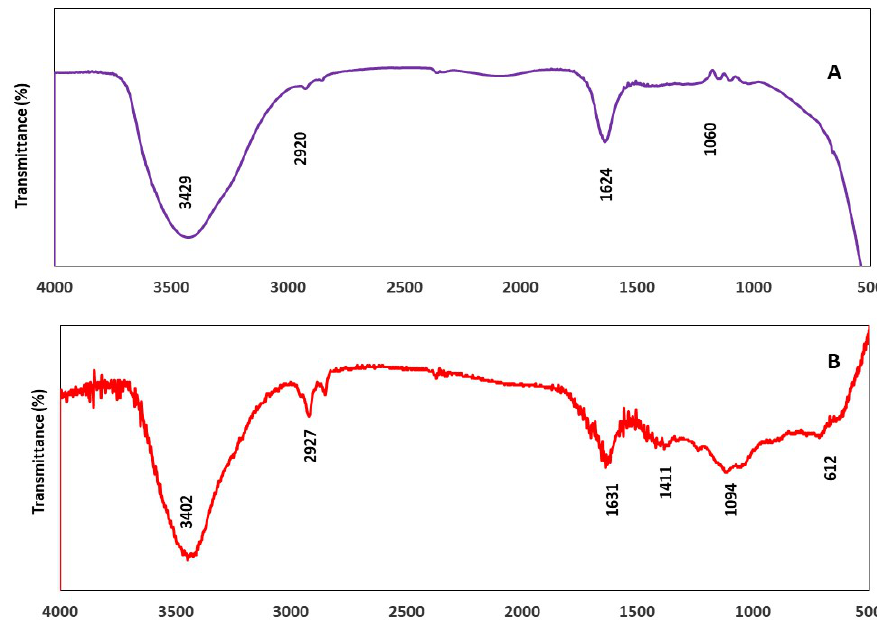
Figure 4. FTIR spectra of Thymus vulgaris extract ( A ) and the synthesized TVE-CuNPs ( B ).